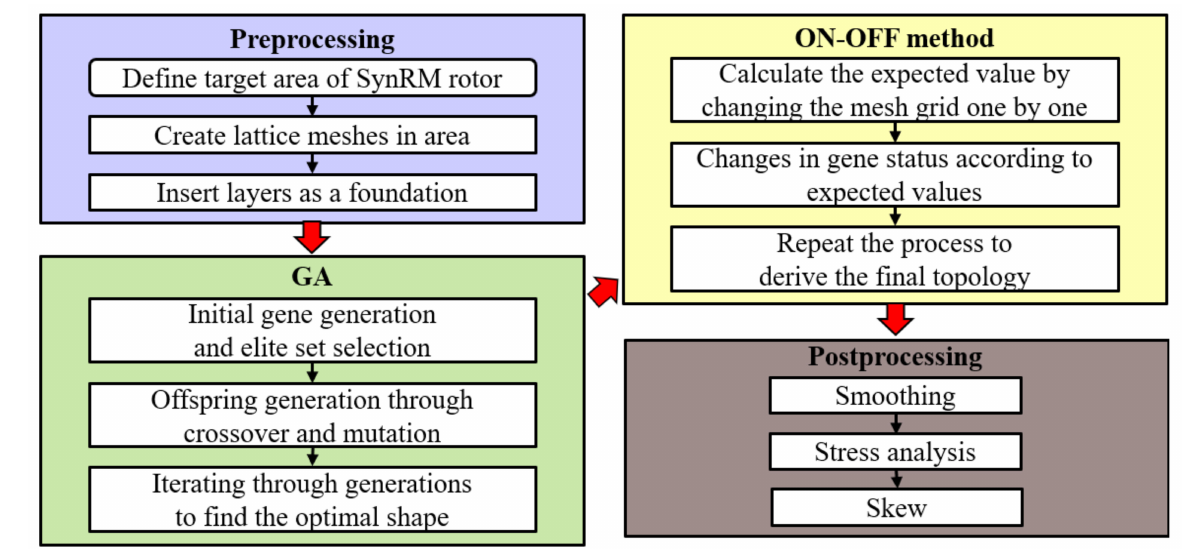
Figure 1. Flow chart of the GTA.